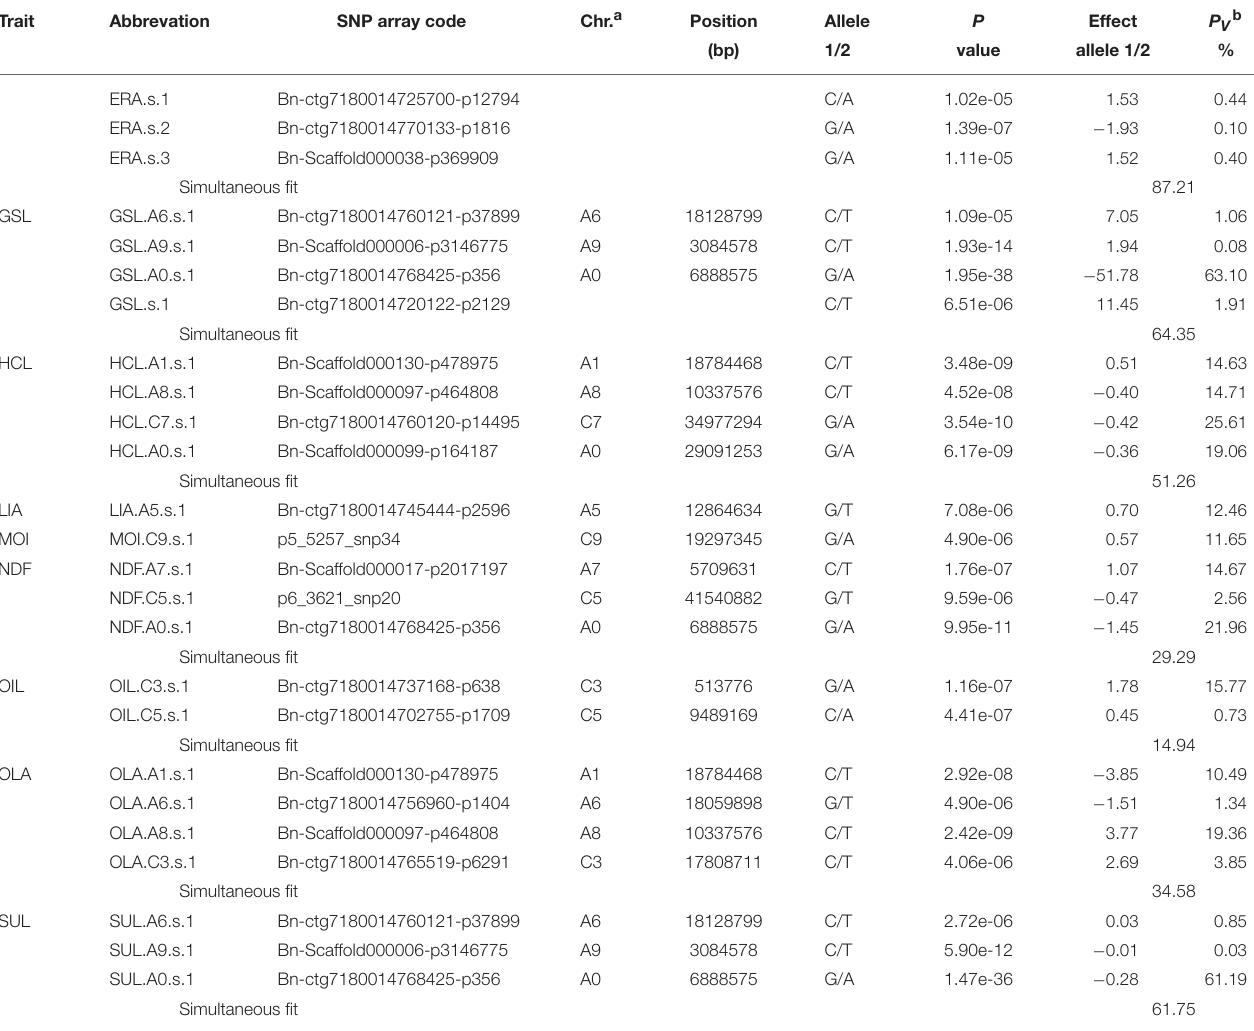
For abbreviations of the traits see Table 1 . a Chr. is the chromosome of the respective SNP; SNPs marked with a A0 or C0 could only be assigned to the genome of B. oleracea or B. rapa but not to a specific chromosome. b P V is the proportion of the explained phenotypic variance